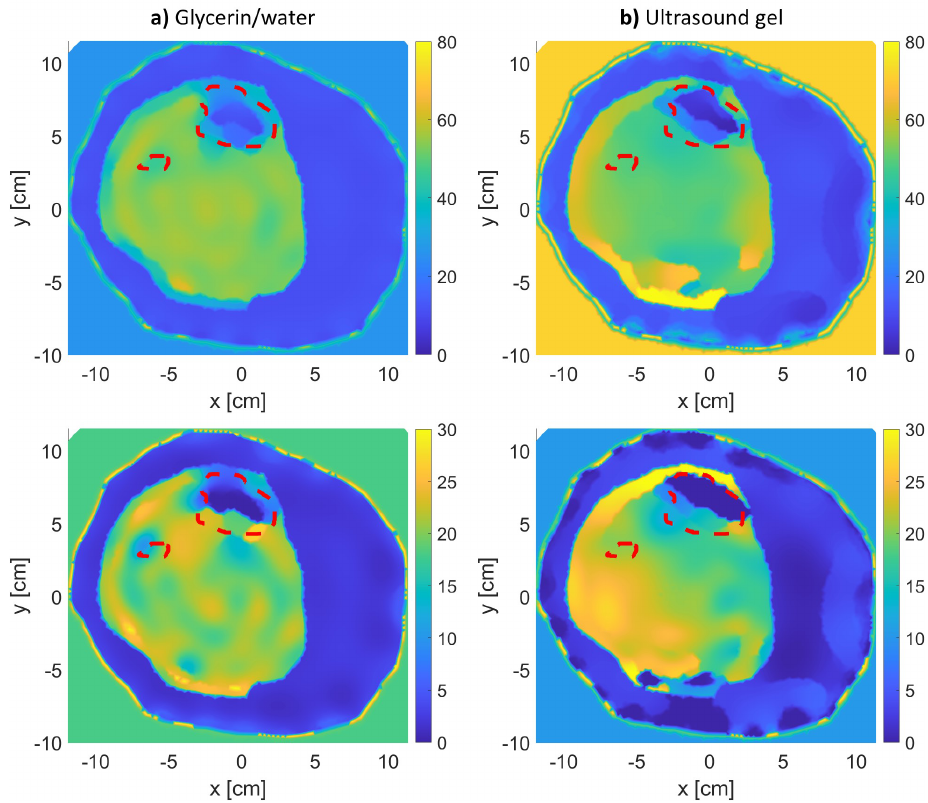
Figure 7. The real ( top row ) and imaginary ( bottom row ) relative complex permittivity results for leg model 3 with the incorporation of prior information about the fat layer for two different matching media: ( a ) glycerin/water solution and ( b ) ultrasound